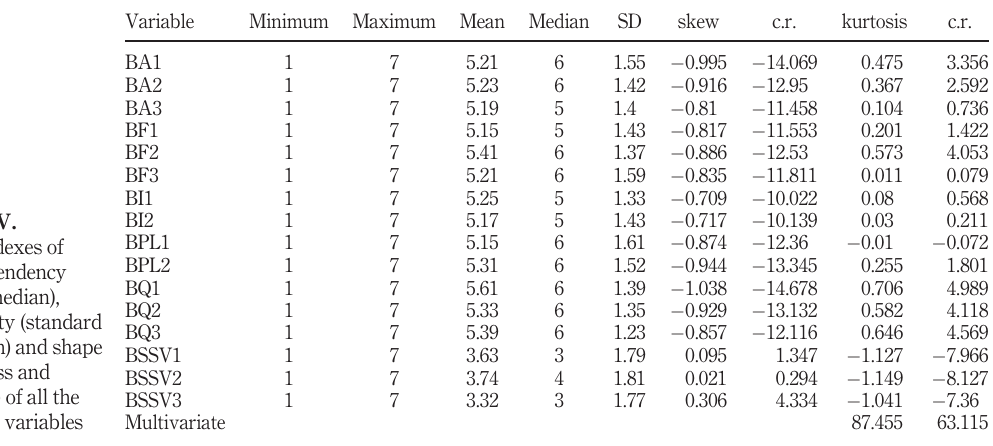
Table IV. Basic indexes of central tendency (mean. median), variability (standard deviation) and shape (skewness and kurtosis) of all the manifest